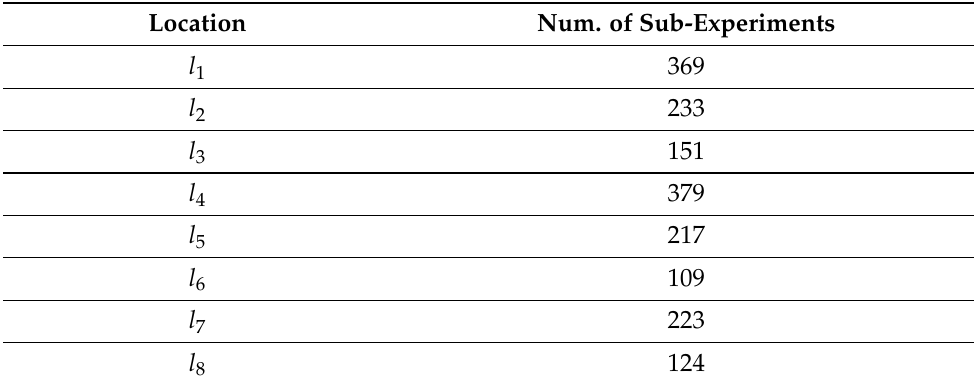
Table 4. Number of sub-experiments for each location used across the simulations.